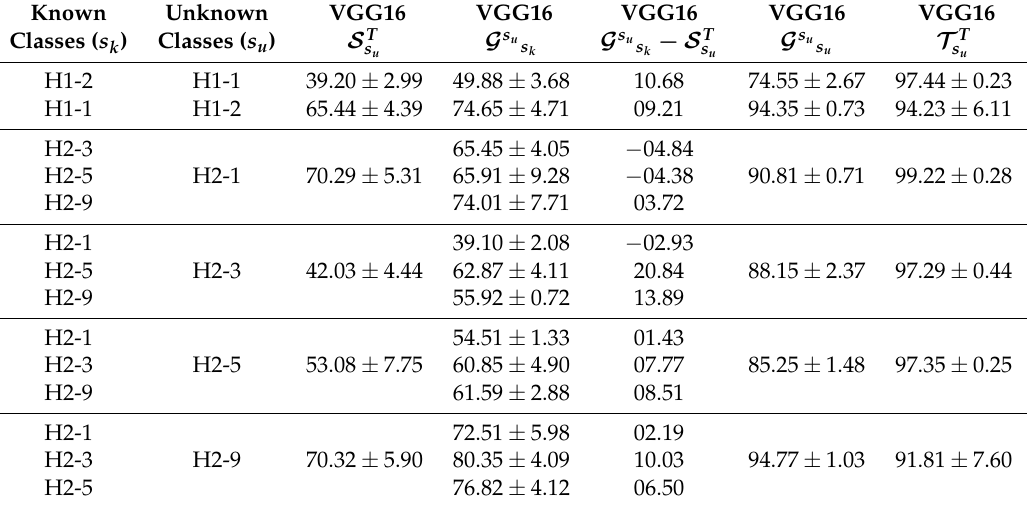
Table 4. Experiments to support Q1 (see main text). All tests are done in T C s deviations of F1 scores are reported, since each experiment is performed five times. The column − S T G s u s s u just stands for the subtraction of the means of the respective columns. k